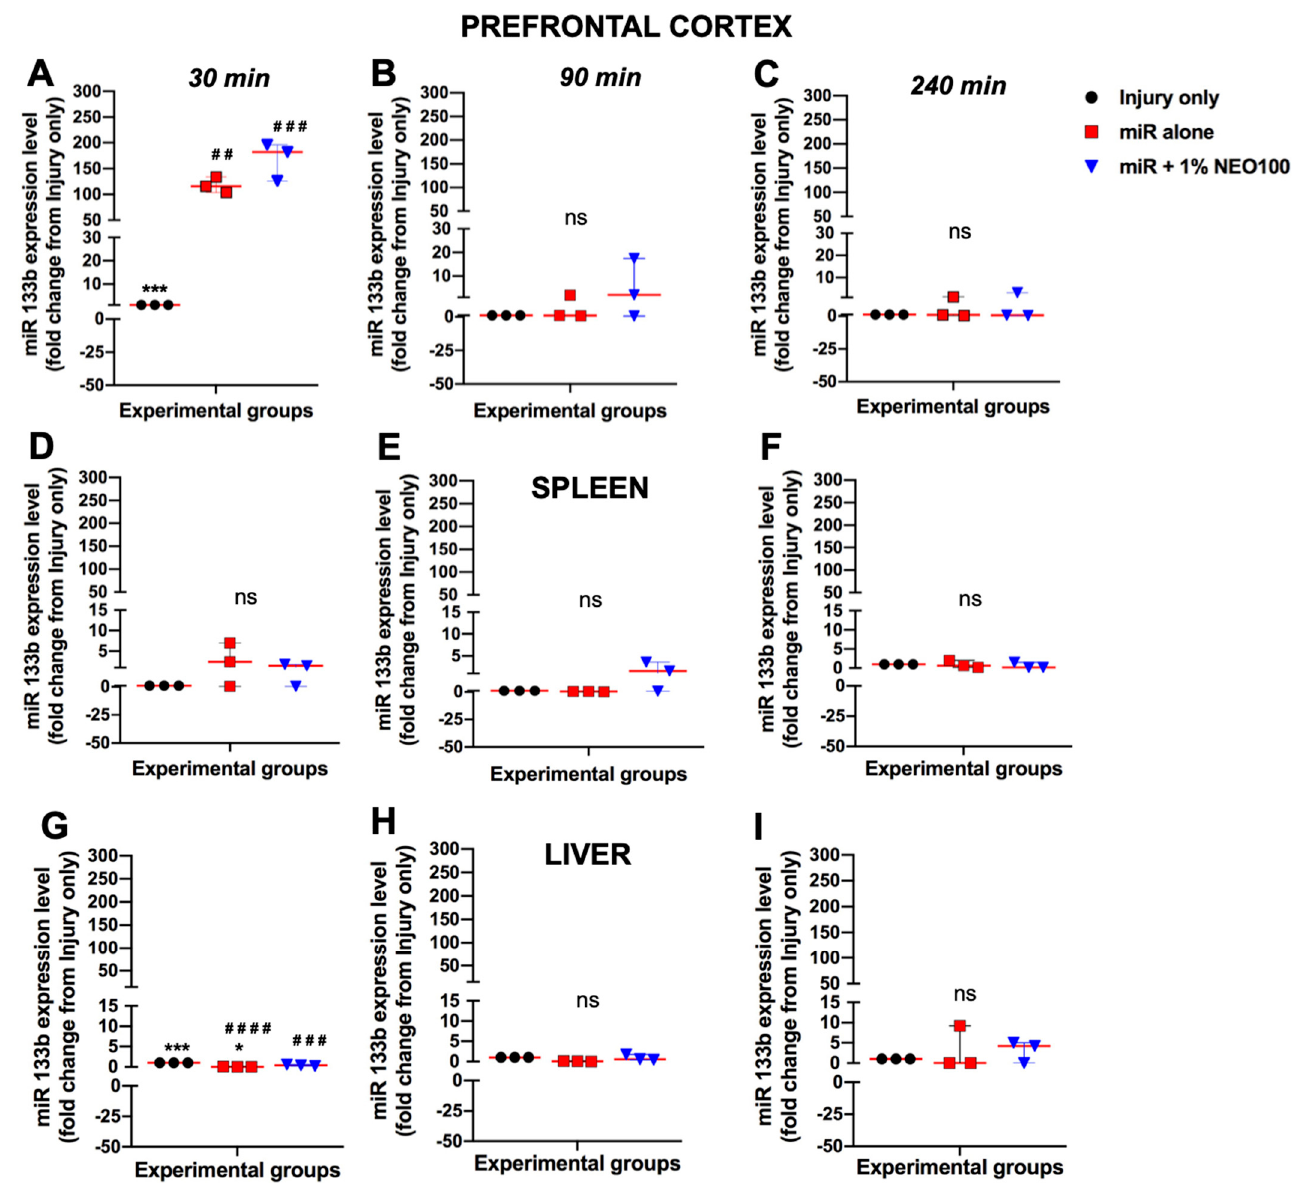
Figure 4. The level of miR133b in the prefrontal cortex, liver and spleen after a single dose of either miR133b/Ago2 or miR133b/Ago2/NEO100 administered intranasally. The prefrontal cortex, liver and spleen were collected from the mice receiving the treatment as presented in Figure 3. The level of miR133b in off targets is represented as follows: Panels ( A – C ) prefrontal cortex; panels ( D – F ) spleen and panels ( G – I ) in liver. The data show the level of miR133b as a fold − change from mice that received injury without any treatment. One − way ANOVA with Dunnett’s multiple comparison test. # # p < 0.01; # ## p < 0.001; #### p < 0.0001 when compared with injury only group; *** p < 0.001; * p < 0.05 when compared with miR +1% NEO100 group. ns = the di ff erence is not statistically sig- ni fi cant among groups. The circles, triangles and squares in each graph represent the individual mouse miR133b level per group. The red line shows the median with interquartile range.